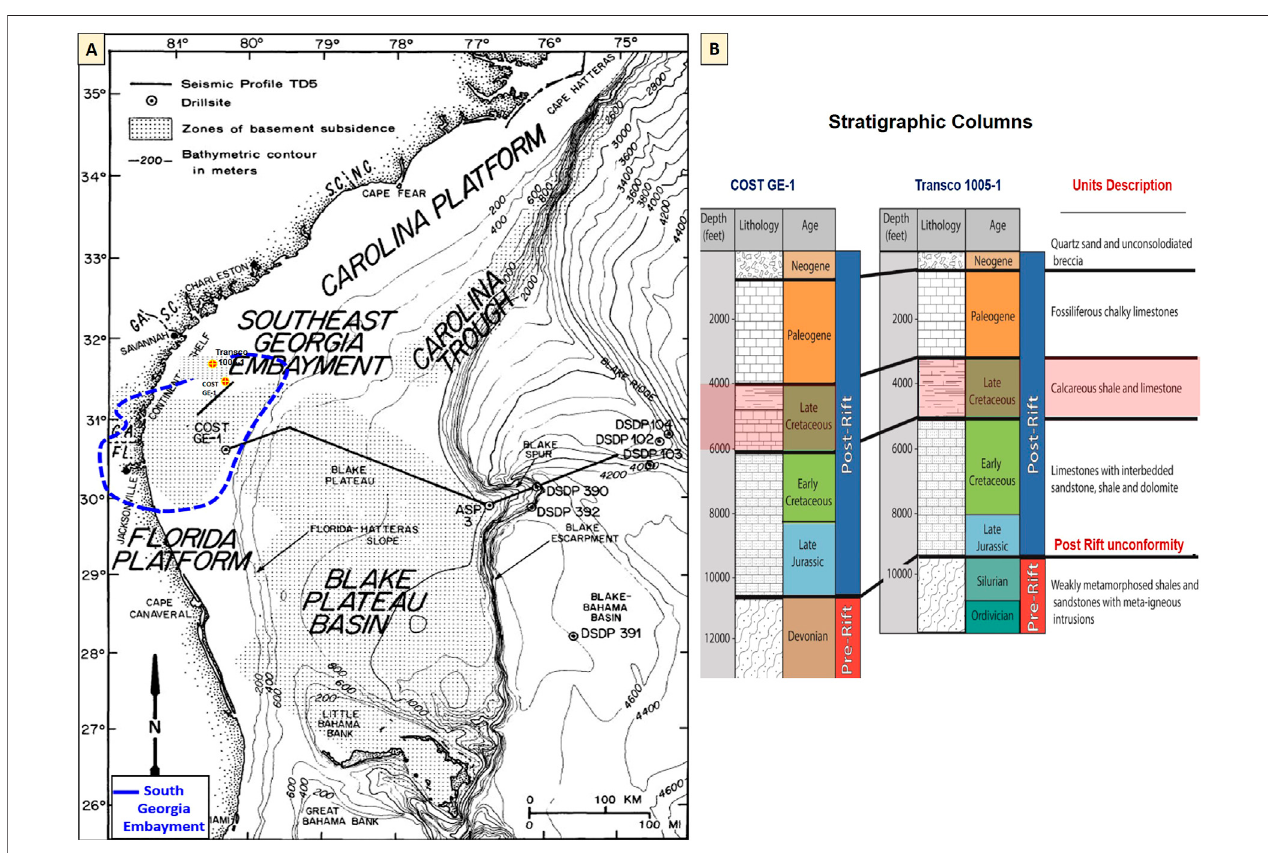
FIGURE1|(A) LocationmapshowingthemainregionalgeologicprovinceswithintheoffshoreareasconsideredforpotentialstorageofCO 2 ,modi fi edfromSmyth et al. (2008) and Dillon et al. (1976). (B) Stratigraphic columns and lithology description at COST GE-1 and Transco 1005-1 wells located at Southeast Georgia embayment, modi fi ed from Pollack (2014). (C) measured core porosity at COST GE-1